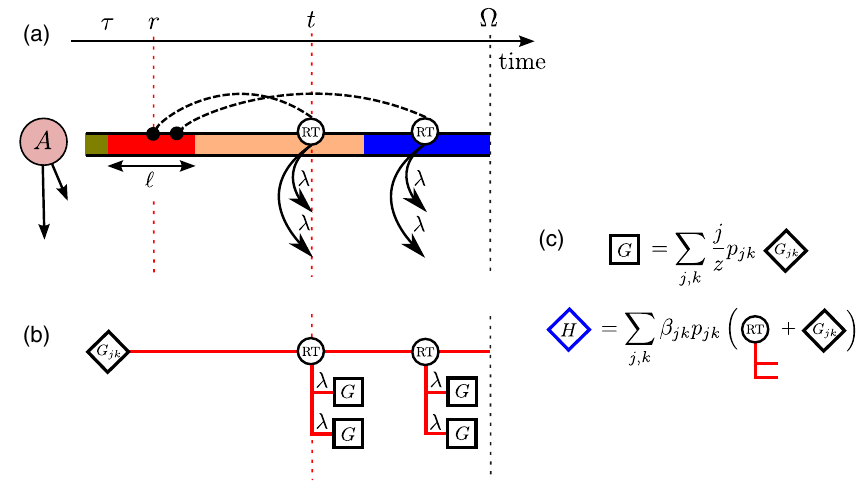
FIG. 3. Schematic for the derivation of the PGF equations (see Sec. III). (a) The stream of user A , showing only memes that were deemed interesting by user A . Each color represents a different meme. At time t , user A decides to retweet a meme from the past and looks back to time r , where she finds meme M (colored red). She sends this meme to her followers (not shown); each follower independently deems the meme interesting with probability λ . Also shown is a later retweet event, which also copies meme M . (b) The retweet tree for meme M , seeded at time τ . Each retweet by user A of meme M generates a new branch on this tree; each branch can also generate further retweets by followers of A , and these subtrees are denoted by squares. (c) Schematic depiction of Eqs. (7) and (16).